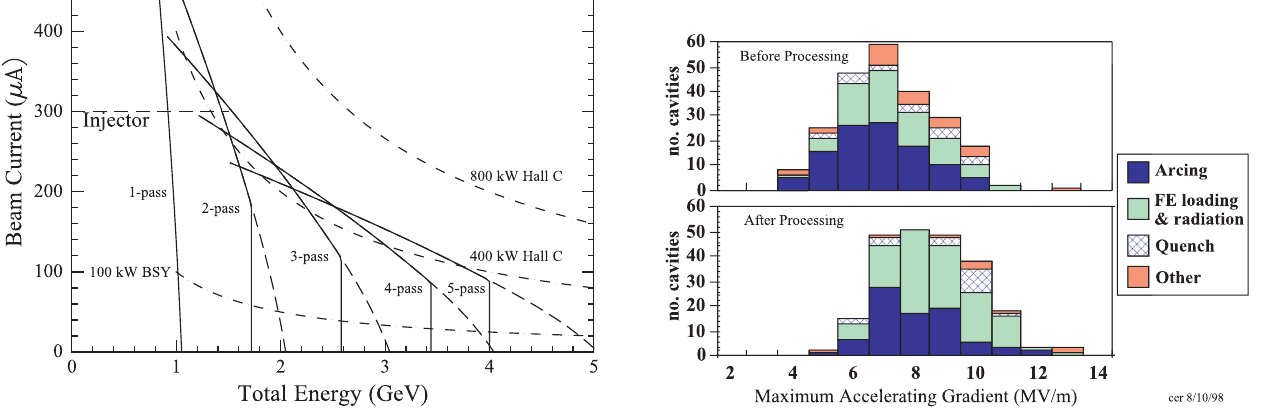
FIG. 13. Cavity performance improvement with helium processing 1996 – 1998 (from